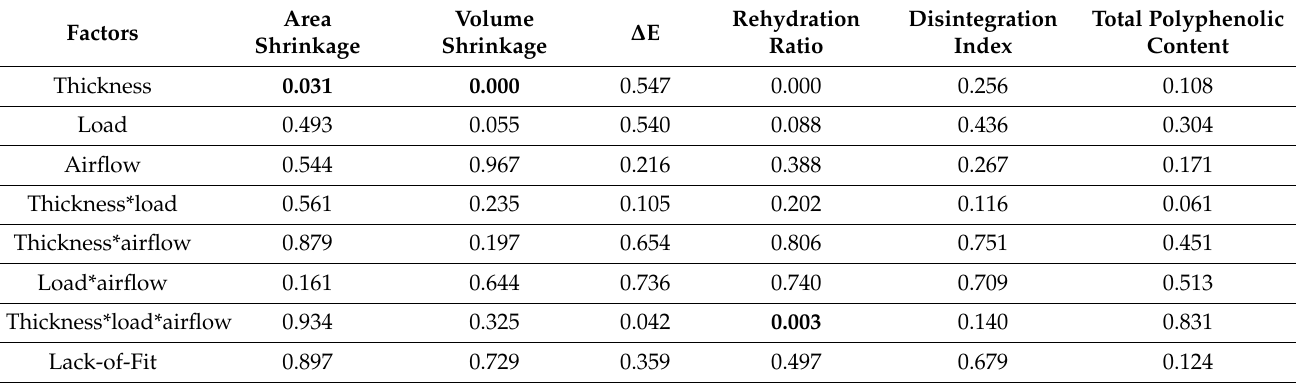
Table 3. The p -values obtained from the multifactorial ANOVA using the general linear model at a 0.05 significance level for quality attributes.